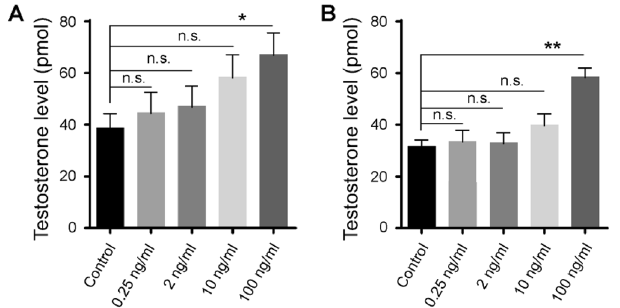
Figure 1. Testosterone levels in isolated ovary ( A ) and brain ( B ) tissues in control (black bars) and drug treated (grey bars) animals. Note the increase of testosterone levels after drug treatment. Data represents the means ± SE (n = 5 in each group). *p < 0.05; **p < 0.01; ns not significant.